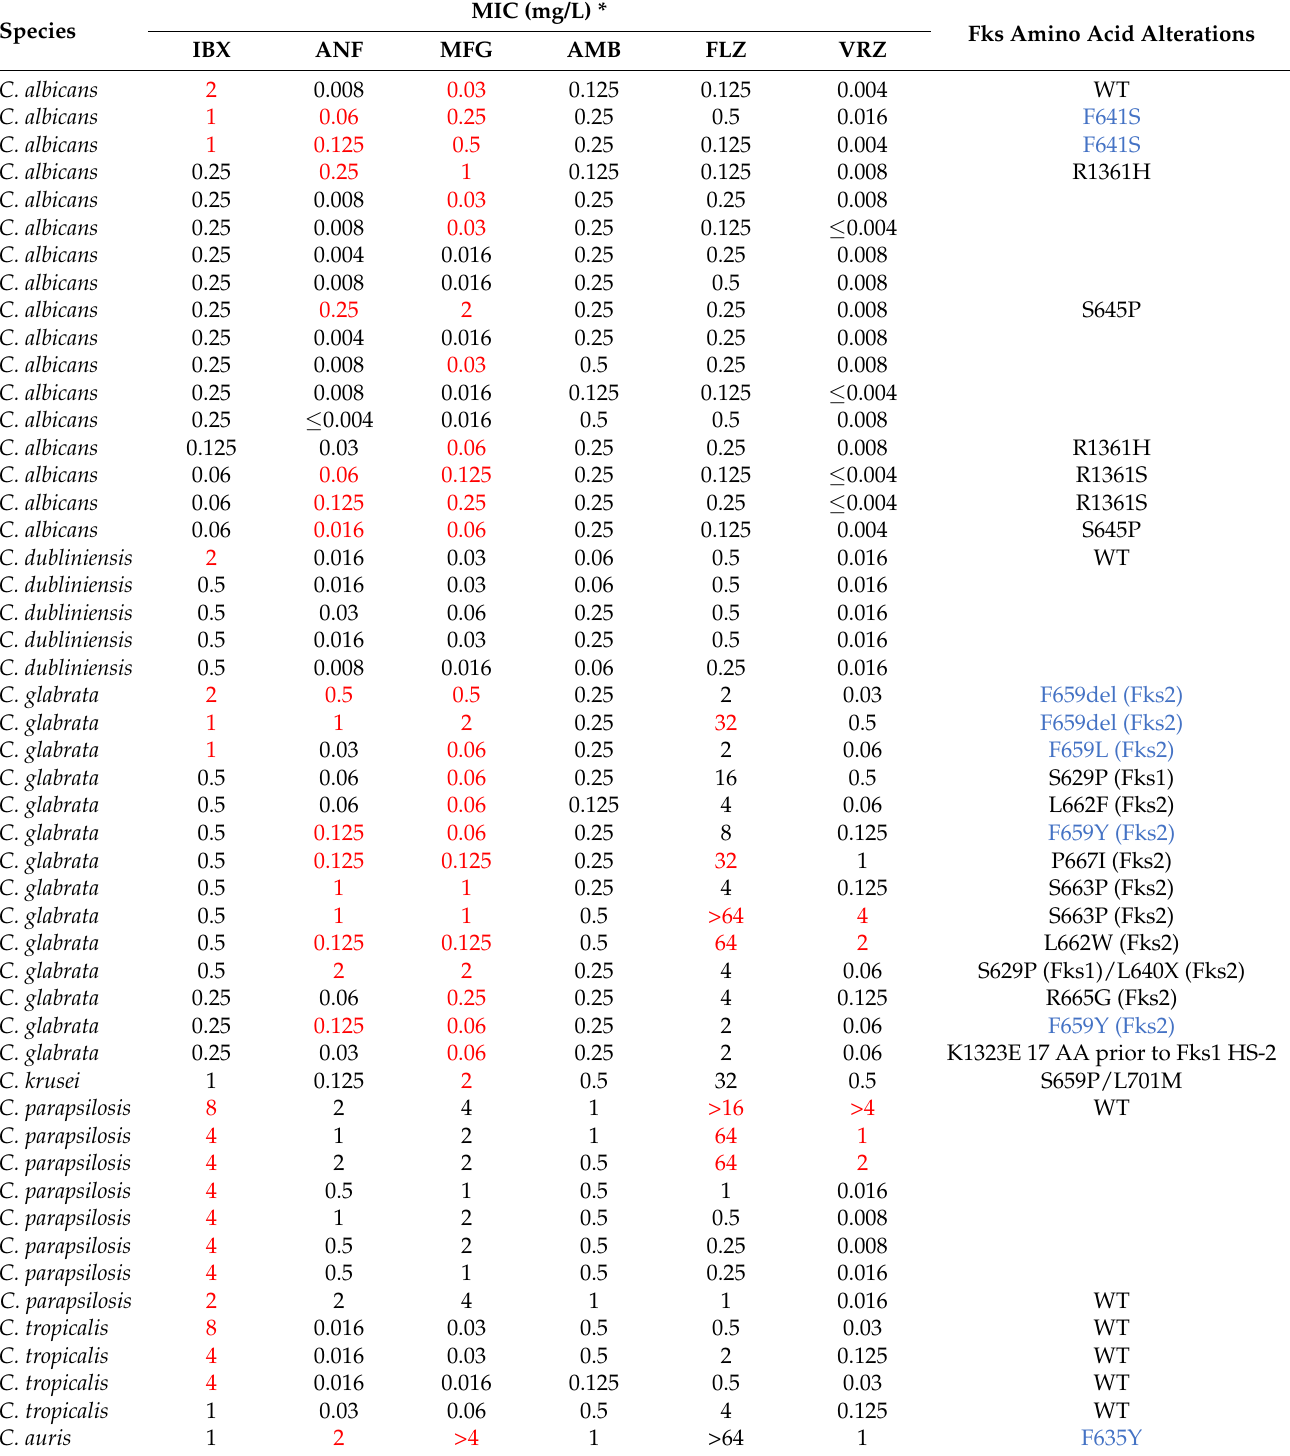
Table 5. MIC and Fks protein details for isolates with elevated MICs to either ibrexafungerp or